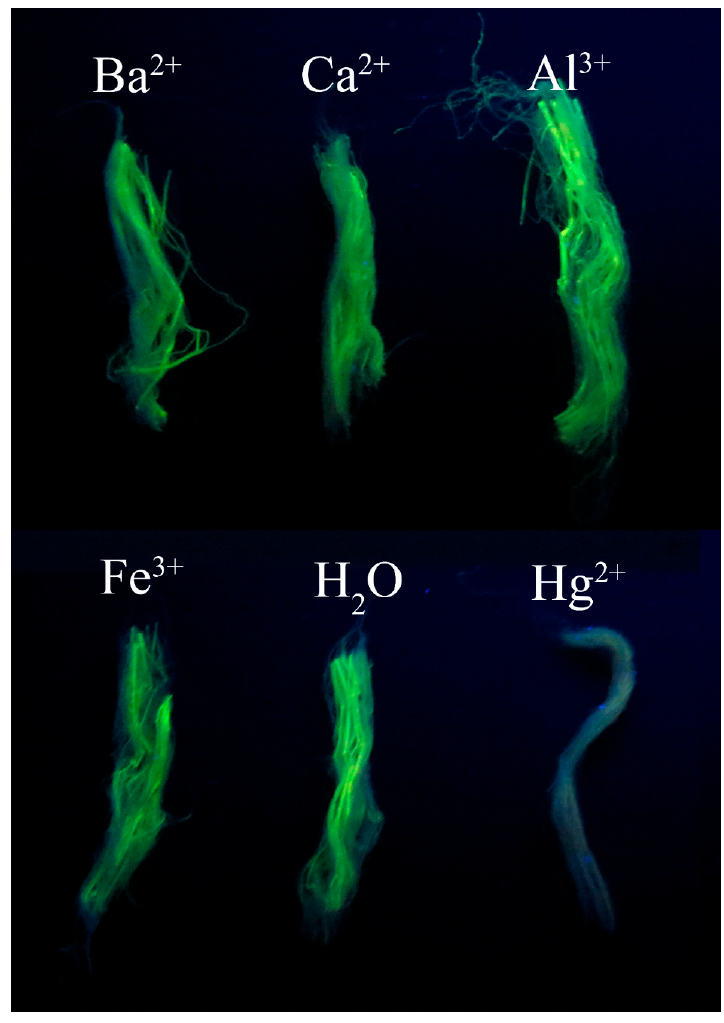
Figure 6. Optical images of green FTFs excited by a UV lamp (365 nm) after doping in different metal ion solutions. The concentrations were 5.0 μ M for Ba 2+ , Ca 2+ , Al 3+ , and Fe 3+ and 1.0 μ M for Hg 2+ .